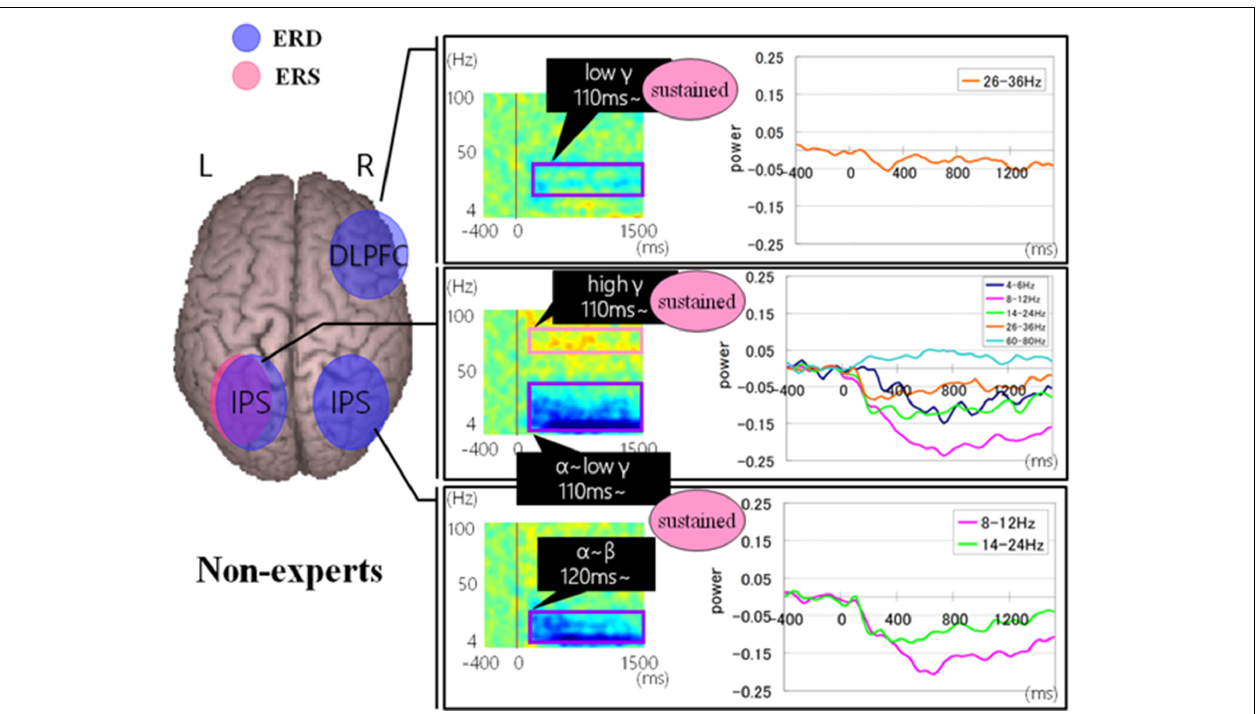
FIGURE 9 | A group average of time-frequency analyses in non-experts during the mental multiplication experiment. The time window is between − 400 and 1500 ms; the movement onset is at 0 ms, and the frequency interval ranges from 4 Hz to 100 Hz. The red areas in the time-frequency maps indicate increases in the high gamma power (ERS), and the blue areas indicate decreases in the beta/alpha/low gamma power (ERD).